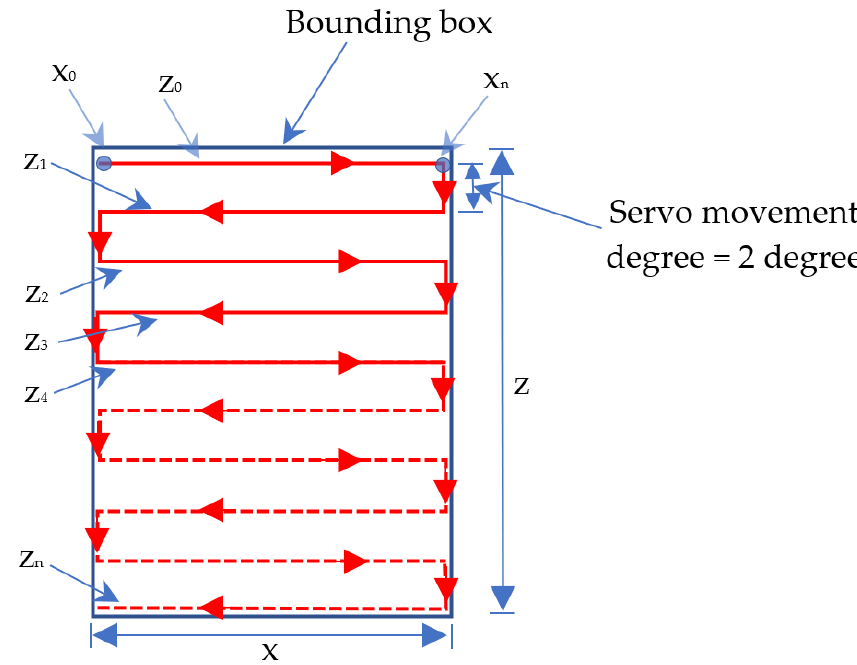
Figure 14. Detail scanning image process path.